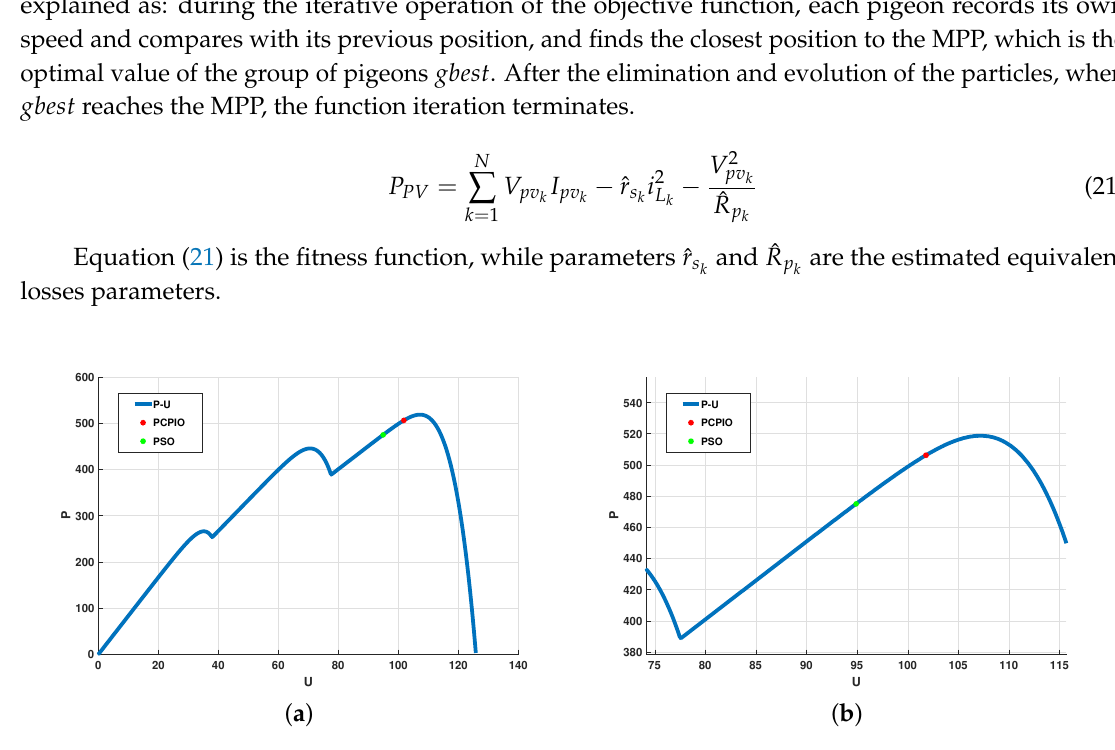
Figure 7. P–V curve of PV array under partial shadow and standard environment. ( a ): PV array under standard environment ( b ): PV array under shadow environment